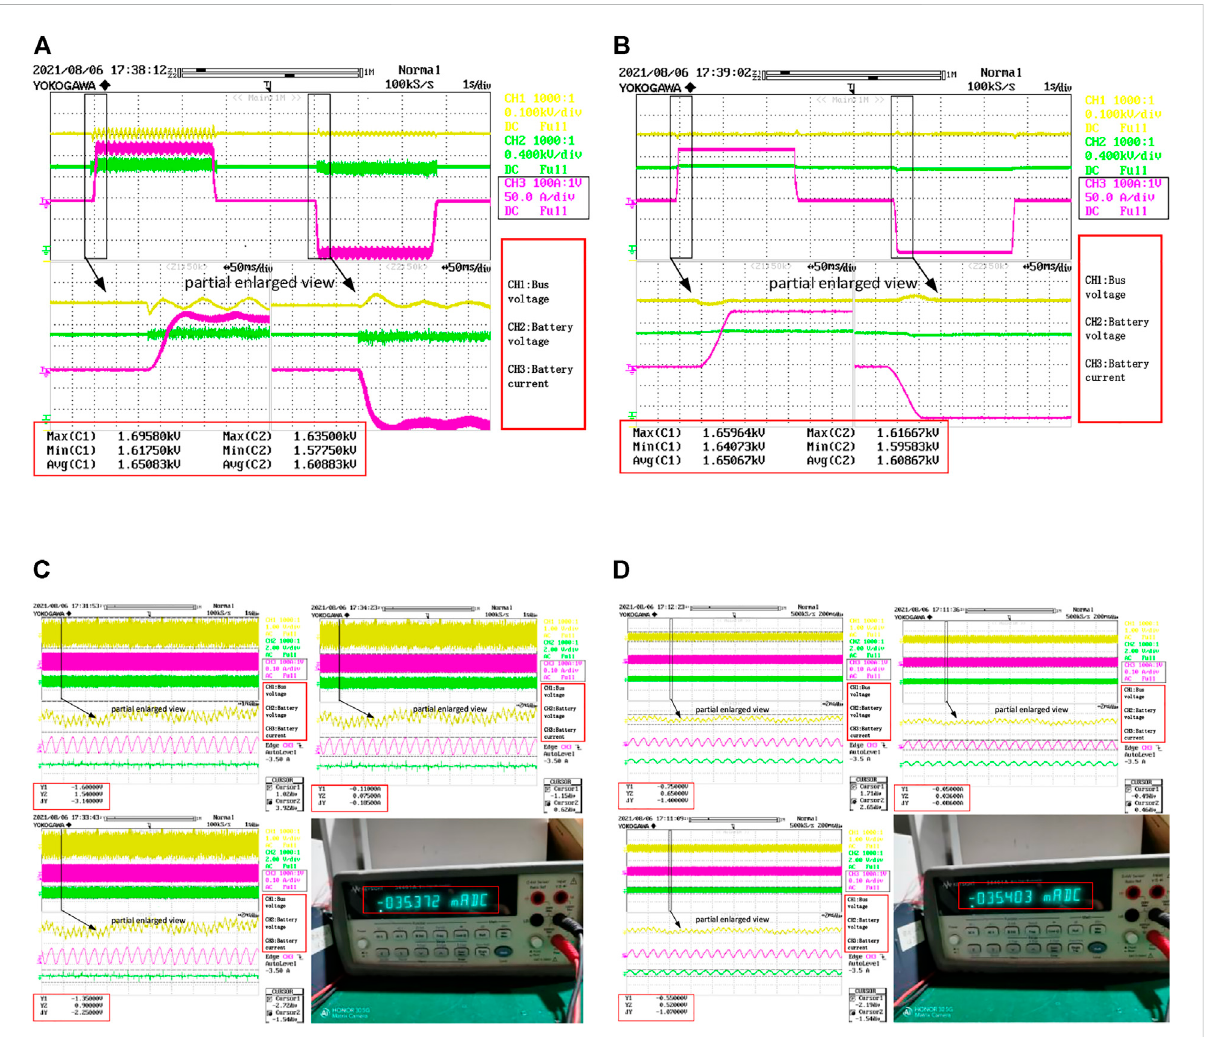
FIGURE 14 Output voltage, current waveforms, and bus waveforms during charging and discharging switching under unbalanced grid conditions ( (A, B) shows the transient response under grid imbalance in the traditional double closed-loop control strategy in Figures 14 and under grid normal in the controlstrategyproposedinthispaperinFigures16,respectively,and (C,D) showtheSteady-statecontrolaccuracyinthetraditionaldoubleclosed- loop control strategy and the control strategy proposed in this paper,